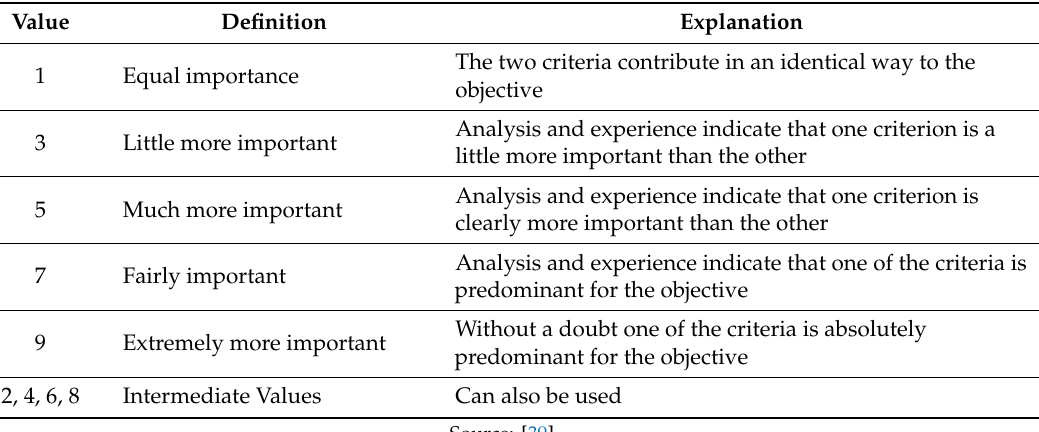
Table 3. Definition and explanation of the di ff erent